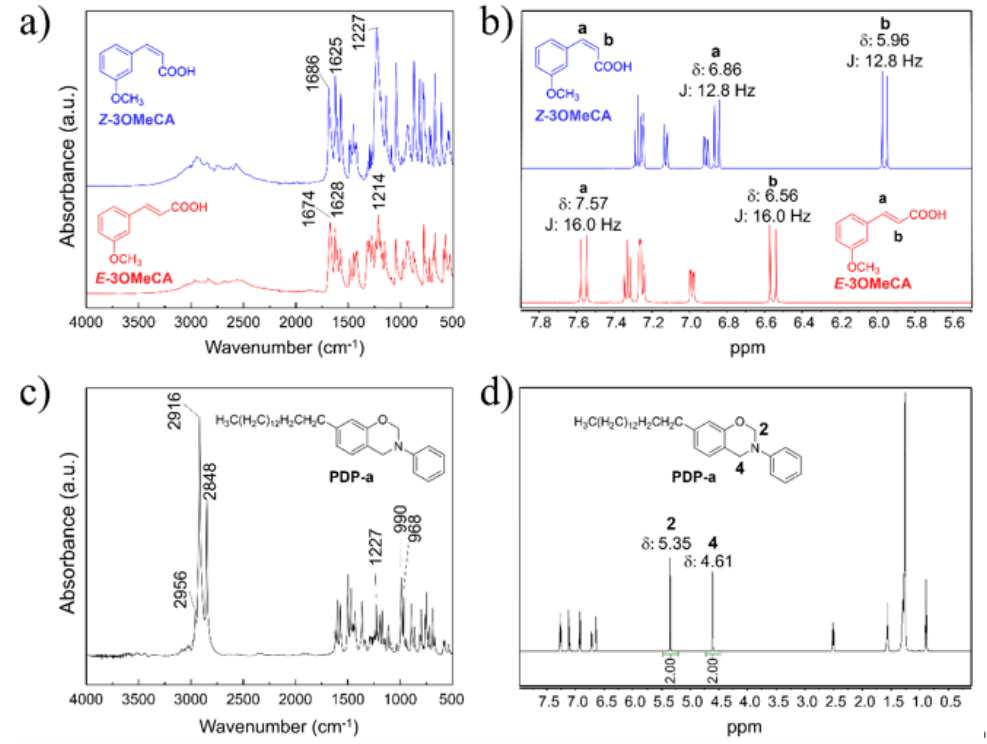
Figure 2. ( a ) FT-IR spectra of E - and Z -3OMeCA. ( b ) 1 H NMR spectra of E - and Z -3OMeCA. ( c ) FT-IR spectrum of PDP-a. ( d ) 1 H NMR spectrum of PDP-a.